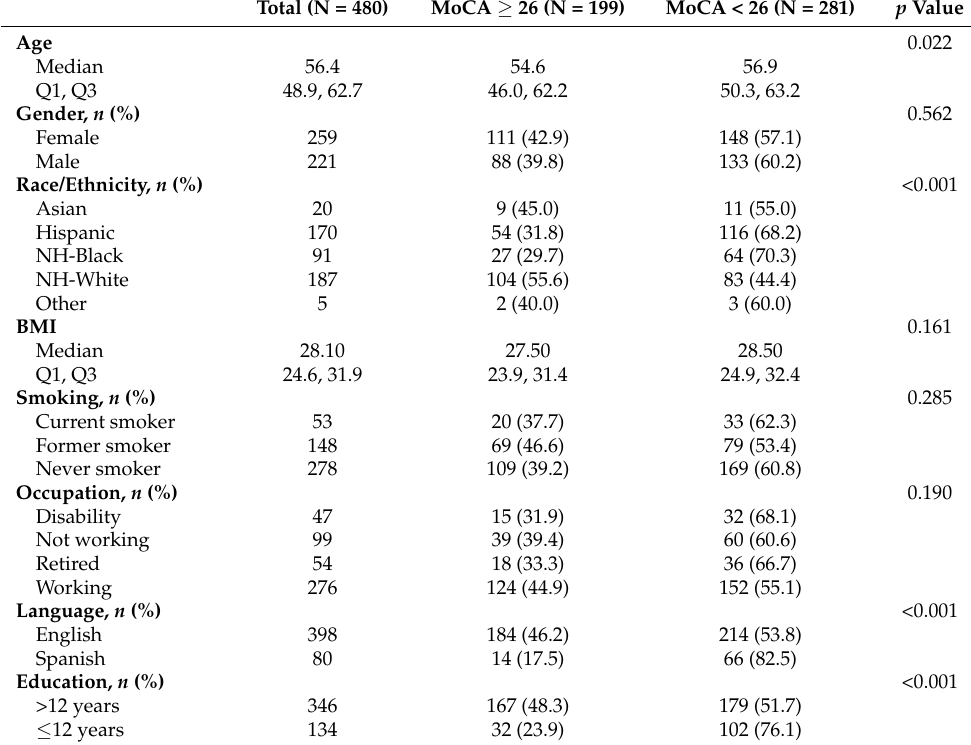
Table 1. Characteristics of study subjects (N = 480) and univariate analysis of MoCA